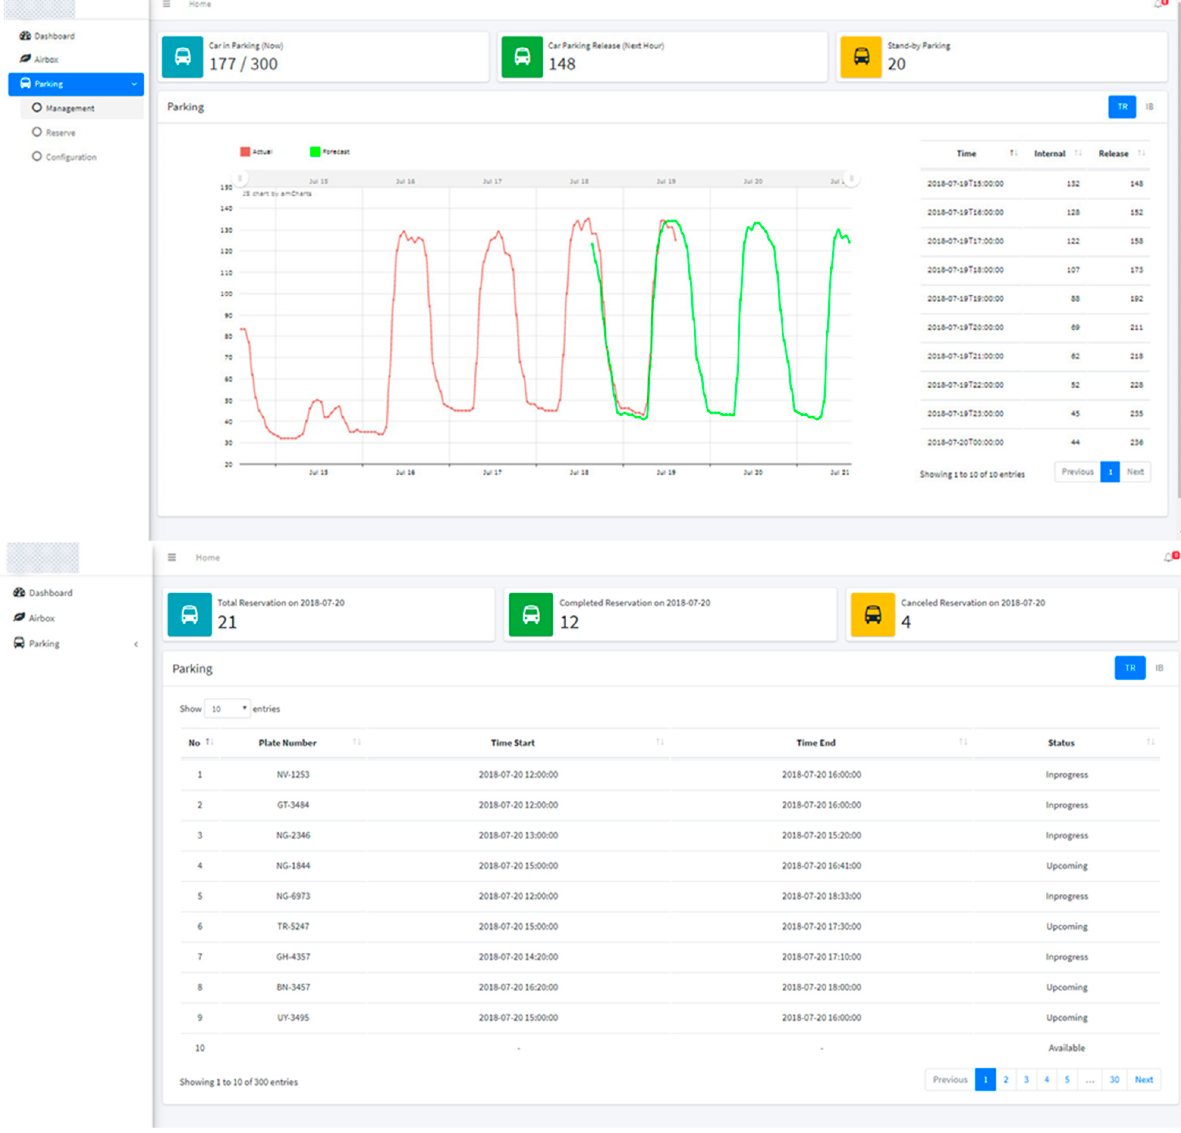
Figure 8. Implementation of parking dashboard using web platform.